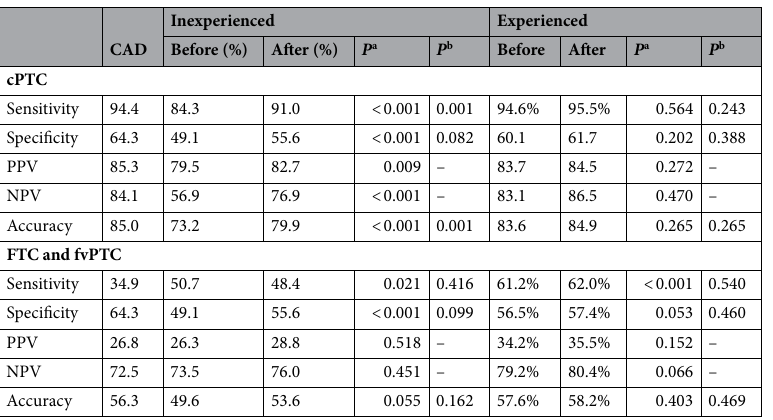
Table 4. Comparisons of diagnostic performances between CAD and physicians before and after CAD assistance according to the pathologic subtype. ACR-TIRADS 4 was used as the cut-off to calculate the diagnostic performance of physicians. CAD, computer-aided diagnosis; Before, physicians before CAD assistance; After, physicians after CAD assistance; PPV, positive predictive value; NPV, negative predictive value; cPTC, conventional papillary thyroid carcinoma; FTC, follicular thyroid carcinoma; fvPTC, follicular variant papillary thyroid carcinoma. P a , CAD vs. before; P b , before vs.